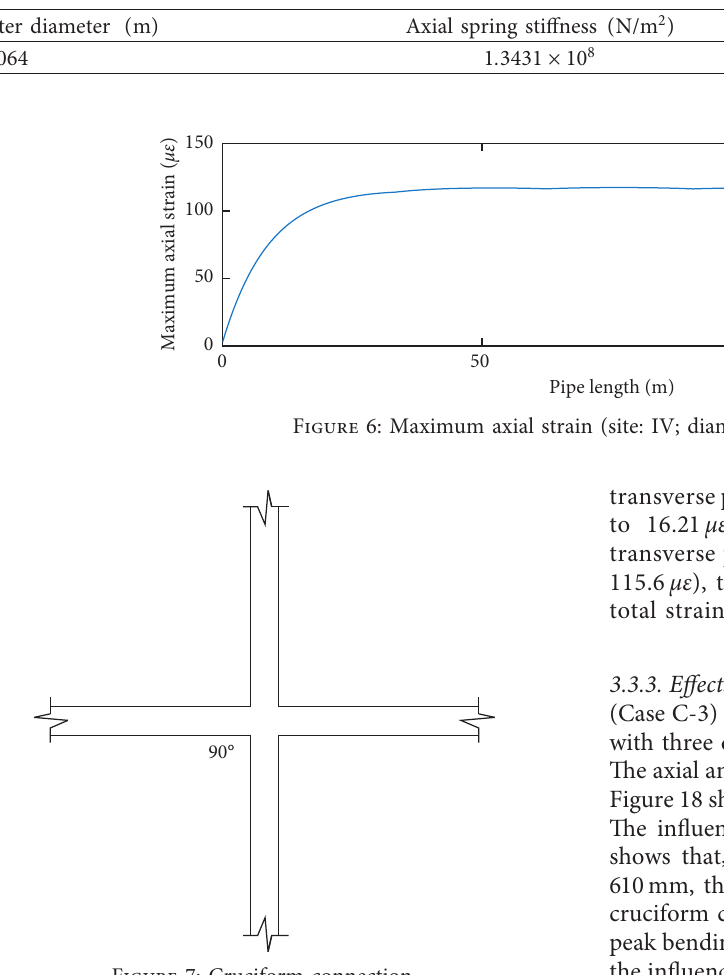
Table 1: Stiffness of soil spring.